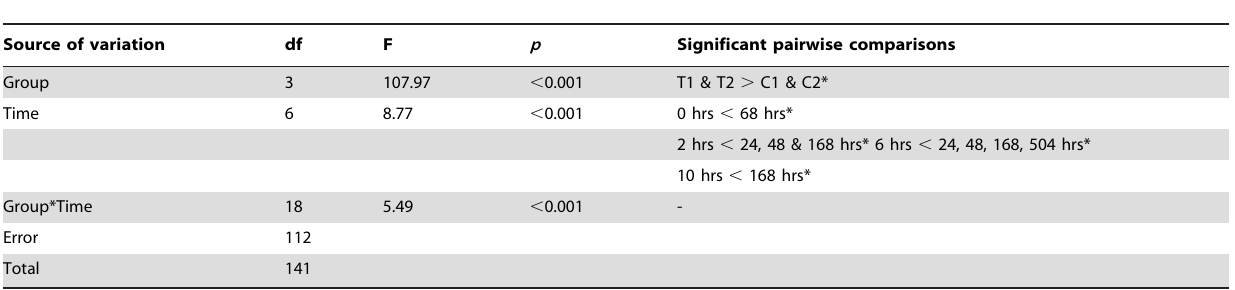
Table 1. Two-way ANOVA for gill scores across groups and sampling times.